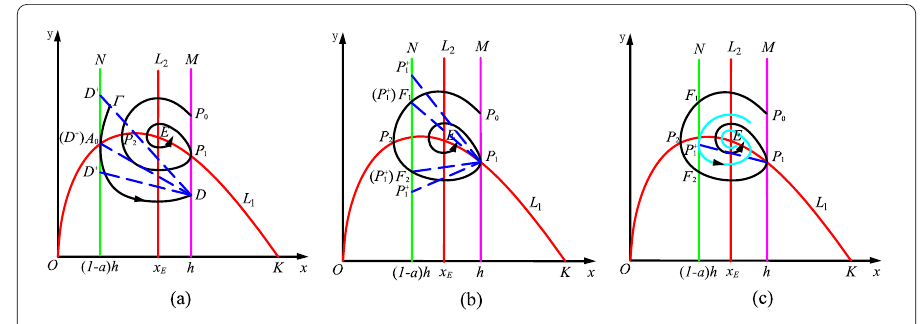
Figure 4 The schematic of the existence of the order-1 periodic solution in Case II. ( a ) Discussion in subcase ≥ (1 – a ) h . ( b ) Discussion in subcase y x P 2